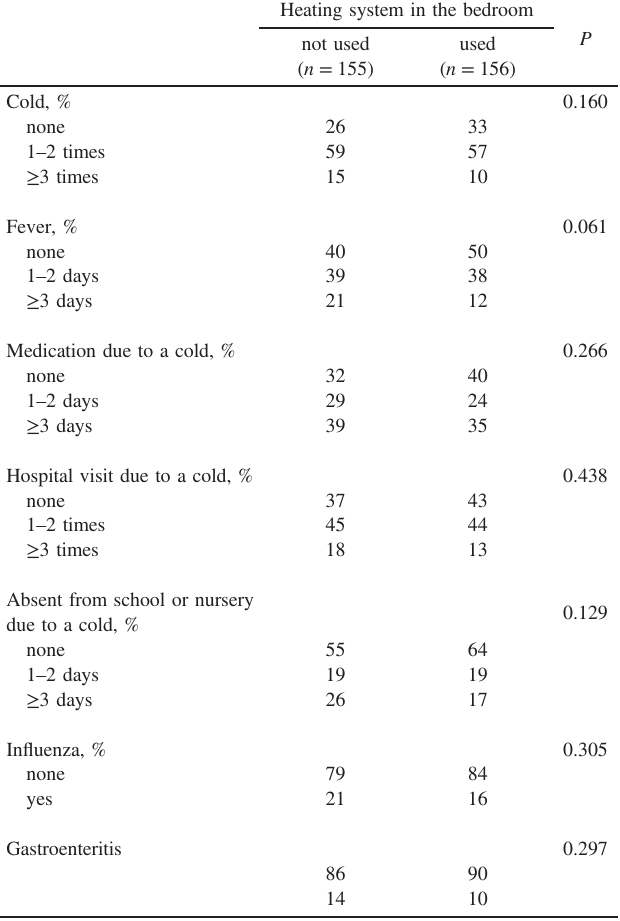
December through February)